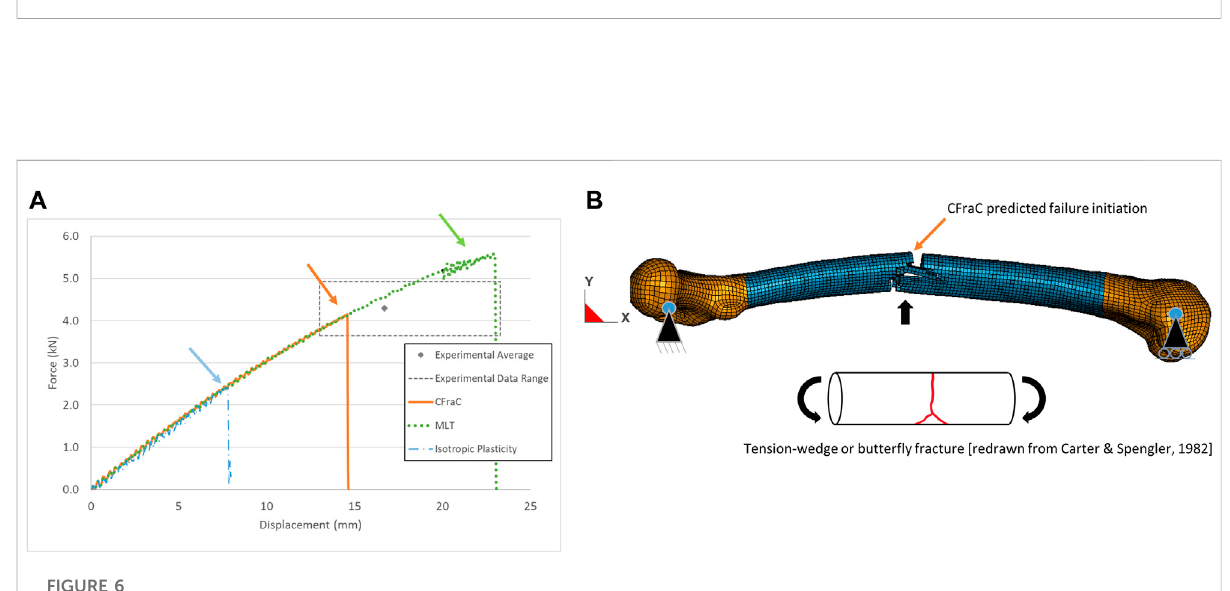
FIGURE 6 Force-displacement response for whole bone posterior-anterior bending test (experimental response from Funk et al., (2004) (A) ; and predicted tension-wedge fracture via eroded elements (B) , fracture initiation location indicated by